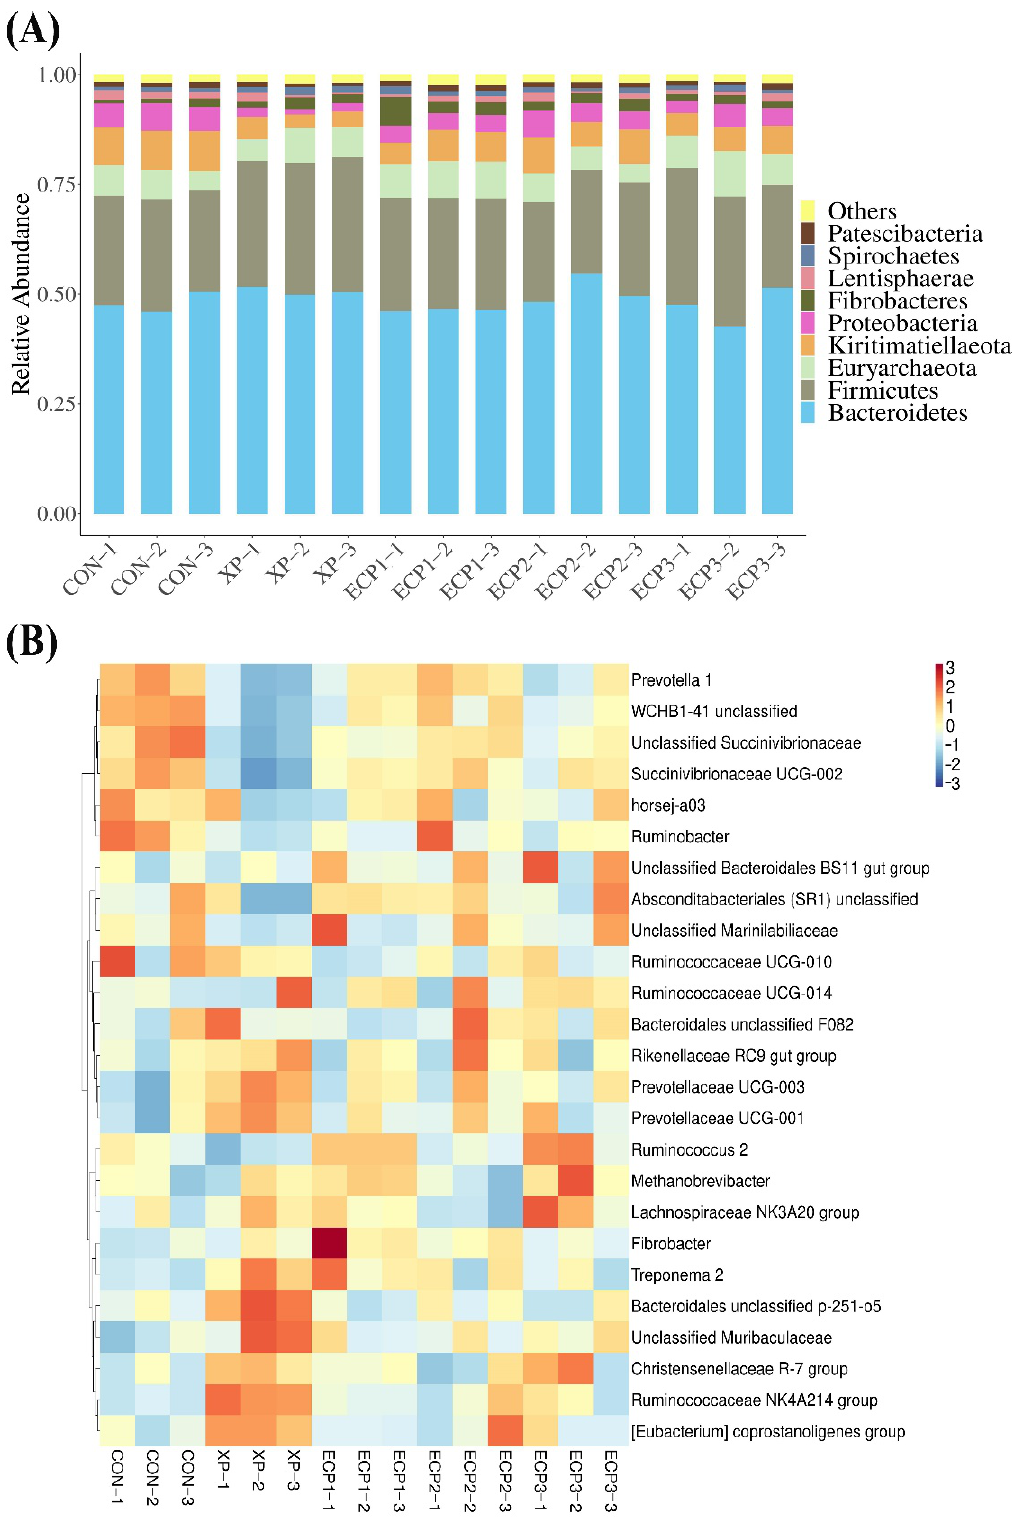
Figure 3. Rumen bacterial compositions at the phylum level ( A ) and heat map of species abundance at the genus level ( B ). CON, without supplementation; XP, XP yeast culture supplementation with 10 g/kg of substrate; ECP1, ECP supplementation with 6 g/kg of substrate, ECP2, ECP supplemen- tation with 12 g/kg of substrate, ECP1, ECP3 supplementation with 18 g/kg of substrate.